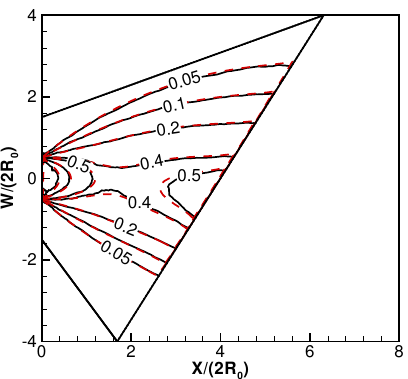
Figure 15. Pressure contours for free jet impingement on an inclined diffuse rectangular reflective plate, from a round exit, in the middle vertical plane. Results normalized by the static pressure at the nozzle exit. Dashed: analytical; solid: DSMC.